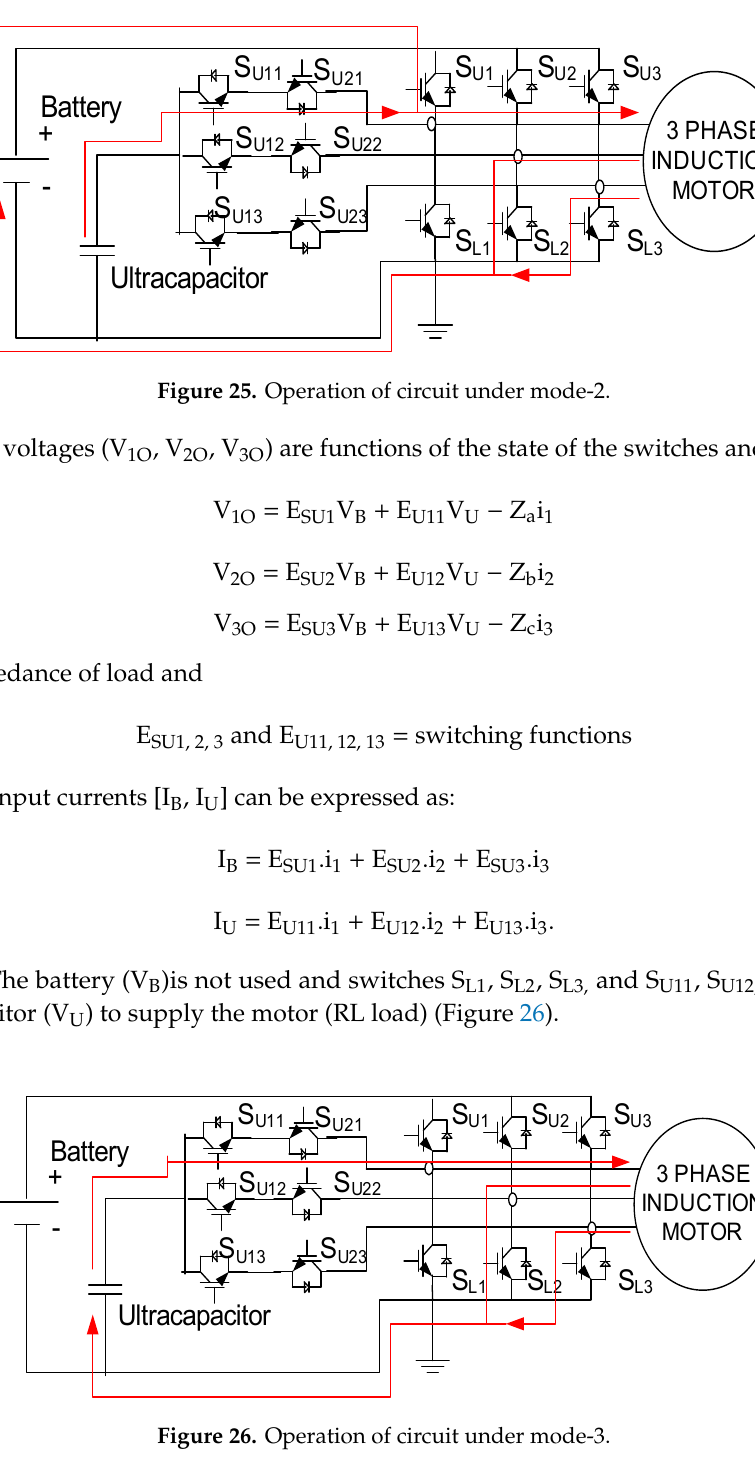
Figure 27. Mode control using the buffer. MOSFET switches are controlled through latch, explained as table 4.